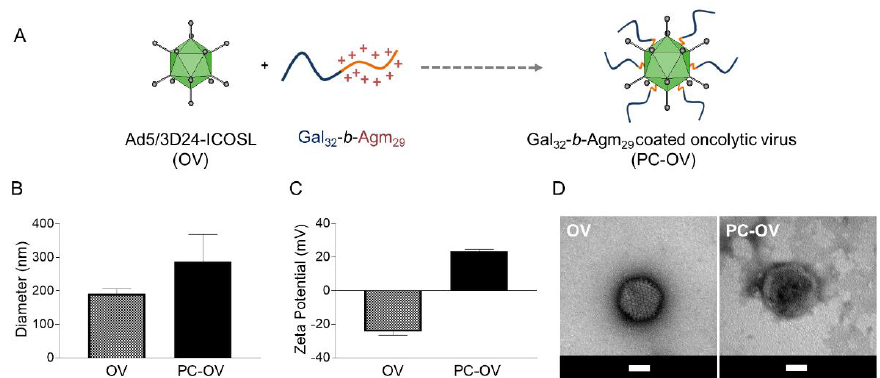
Figure 1. Surface modified oncolytic adenovirus (OV) as targeting strategies. ( A ) Schematic representation of the strategy to generate the OVs surface with ASPGR-targeting macromolecules. A cation block was added to the polymer to confer a positive charge that favors the interaction with the negatively charged capsid of the virus, allowing the formation of a complex (PC-OV). ( B , C ) Viral particles were coated with an excess of Gal 32 -b-Agm 29 polymer chains. After the reaction, zeta potential ( B ) and particle size ( C ) were measured. Data are reported as mean ±SD. ( D ) Electron microscopy pictures of naked virus and PC-OV (scale bar 50 nm).